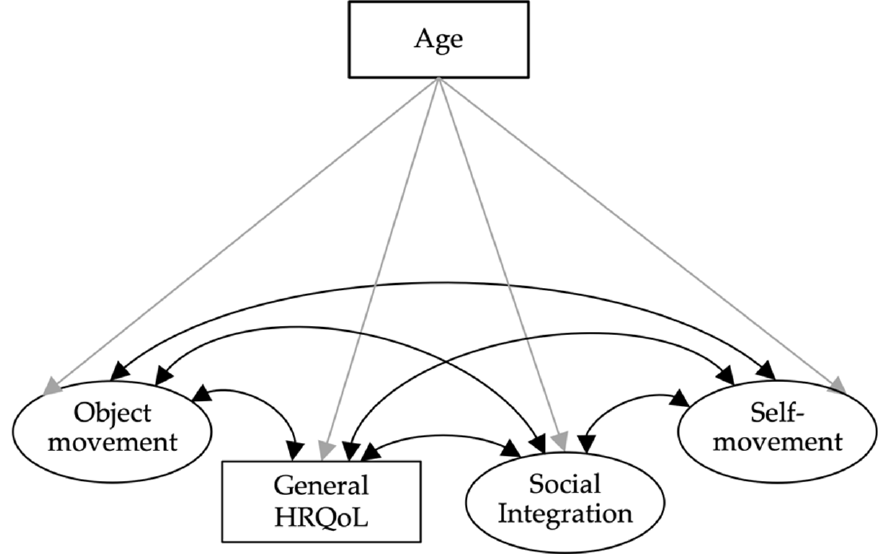
Figure 1. Model 1. Structural equation model with object movement, self-movement, general HRQoL, and social integration with the covariate age.